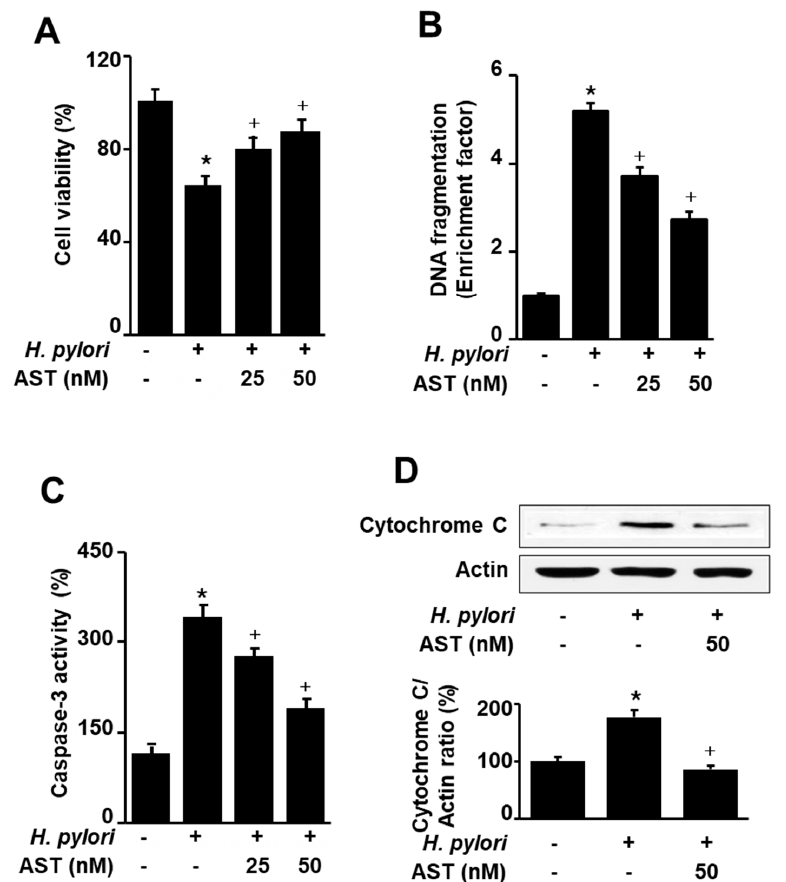
Figure 2. E ff ect of astaxanthin on H. pylori -induced cell death, DNA fragmentation, caspase-3 activation, and cytochrome C release in AGS cells. The cells were pre-treated with the indicated concentrations of astaxanthin for 3 h and then stimulated with H. pylori (cell to H. pylori ratio of 1:50) for 24 h. ( A ) Cell viability was measured using trypan blue exclusion assay. Cell viability of control group (cells without H. pylori stimulation) was set at 100%. ( B ) DNA fragmentation was assessed by relative levels of nucleosome-bound DNA in cell lysates. DNA fragmentation of control group (cells without H. pylori stimulation and without any treatment) was set at 1. ( C ) Caspase-3 activity was measured by caspase-3 activity assay kit. Caspase-3 activity of control group (cells without H. pylori stimulation and without any treatment) was set at 100%. ( D ) Cytochrome C release was determined with Western blotting. Actin was used as a loading control. The ratios of cytochrome C release / actin were determined from band densities of these proteins. Control (cells without H. pylori stimulation and without any treatment) was set at 100. * p < 0.05 vs. control; + p < 0.05 vs. cells with H. pylori stimulation and without any treatment. Astaxanthin